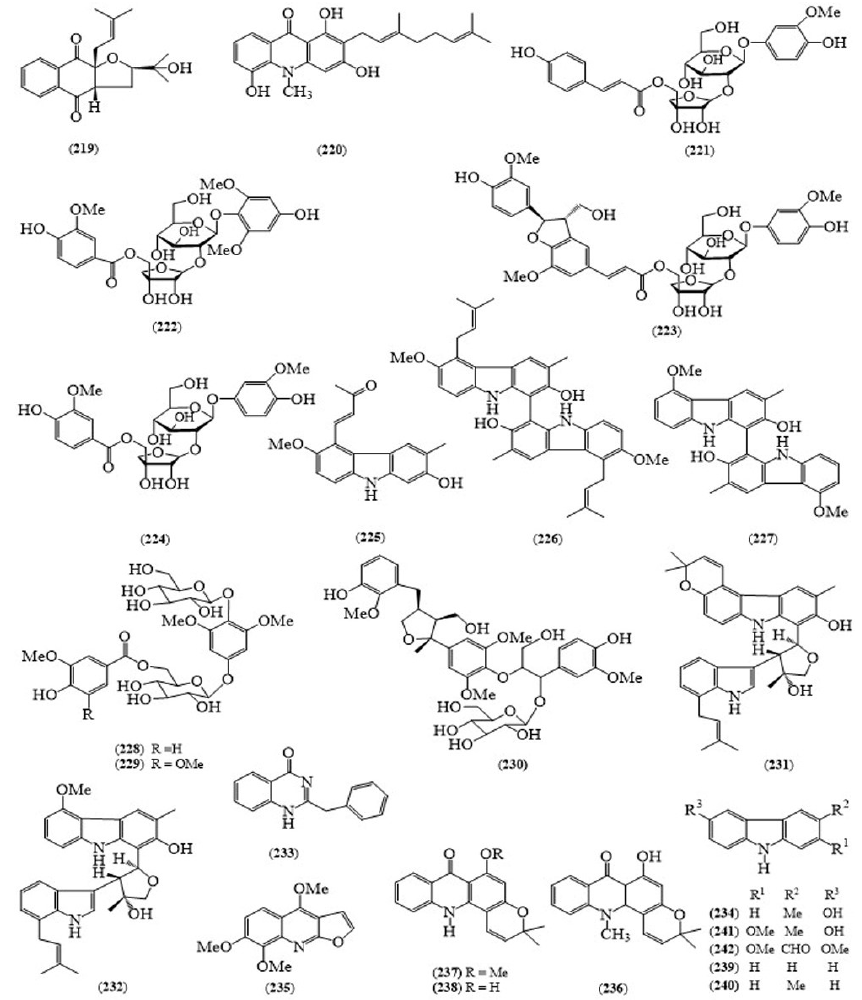
Figure 16. Structures of selected compounds isolated from Glycosmis pentaphylla.